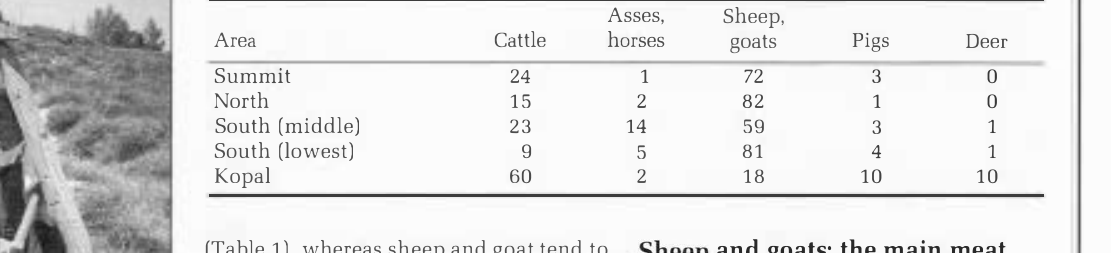
Sheep and goats: the main meat supply Sheep and goats were the most common food animals at <::atalhi:iyuk (Table 1)